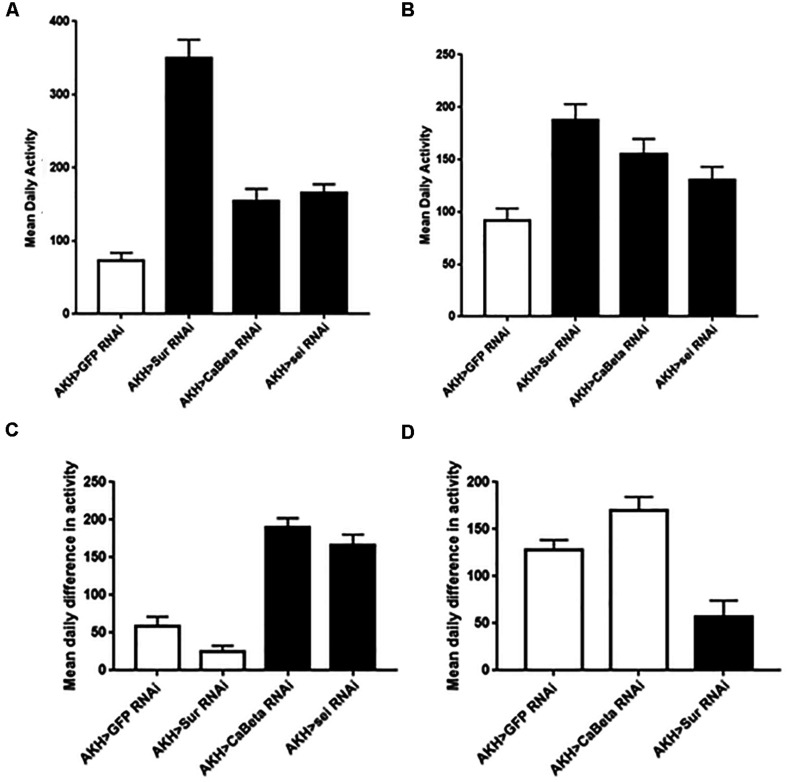
Locomotor activity in animals expressing the Sur-RNAi, sei-RNAi, and Ca-beta RNAi elements under replete and starvation conditions. Locomotor activity was monitored for 3 days with ad libitum food and mean daily activity (beam breaks for 24 h) was assessed for females (A) and males (C). Black bars denote significant differences (P < 0.05) from control animals (One Way ANOVA). Locomotor activity during starvation conditions was also assessed in females (B) and in males (D). The hypersensitivity of sei-RNAi to starvation precluded measuring daily activity during starvation). Black bars denote significant differences (P < 0.05) from control animals (One Way ANOVA).